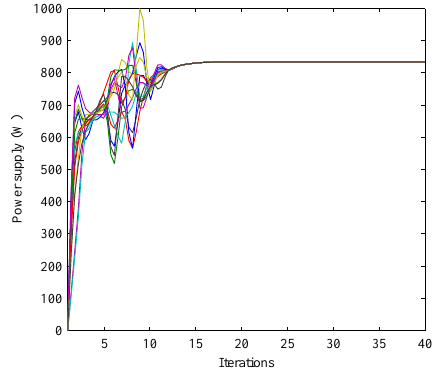
Figure 12. The convergence of the power